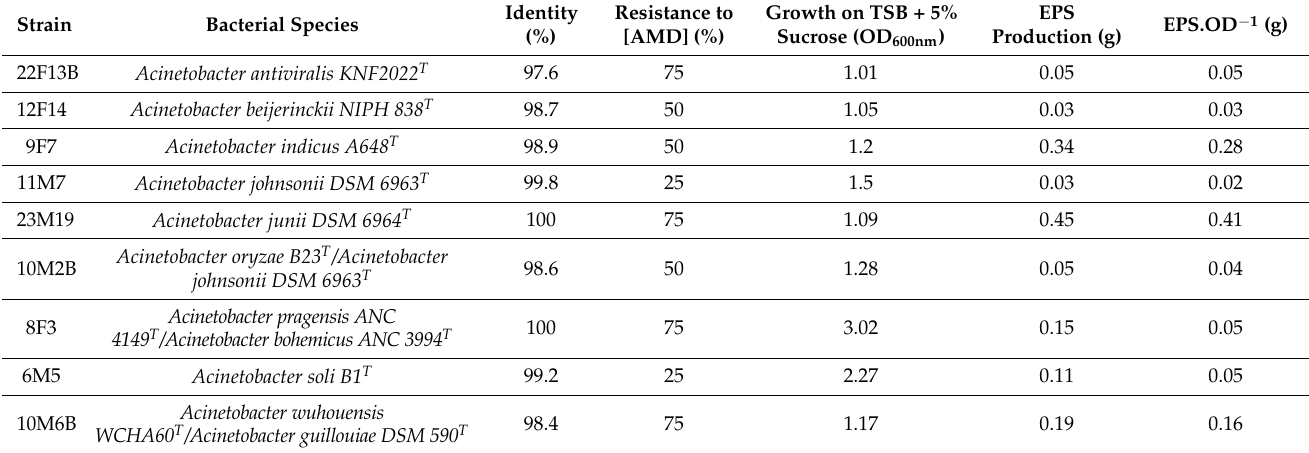
Table 1. Core cultivable microbiota strains producing exopolysaccharide